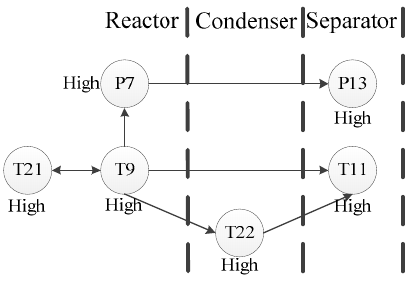
Figure 15. Fault 4 graphical scenario object model.